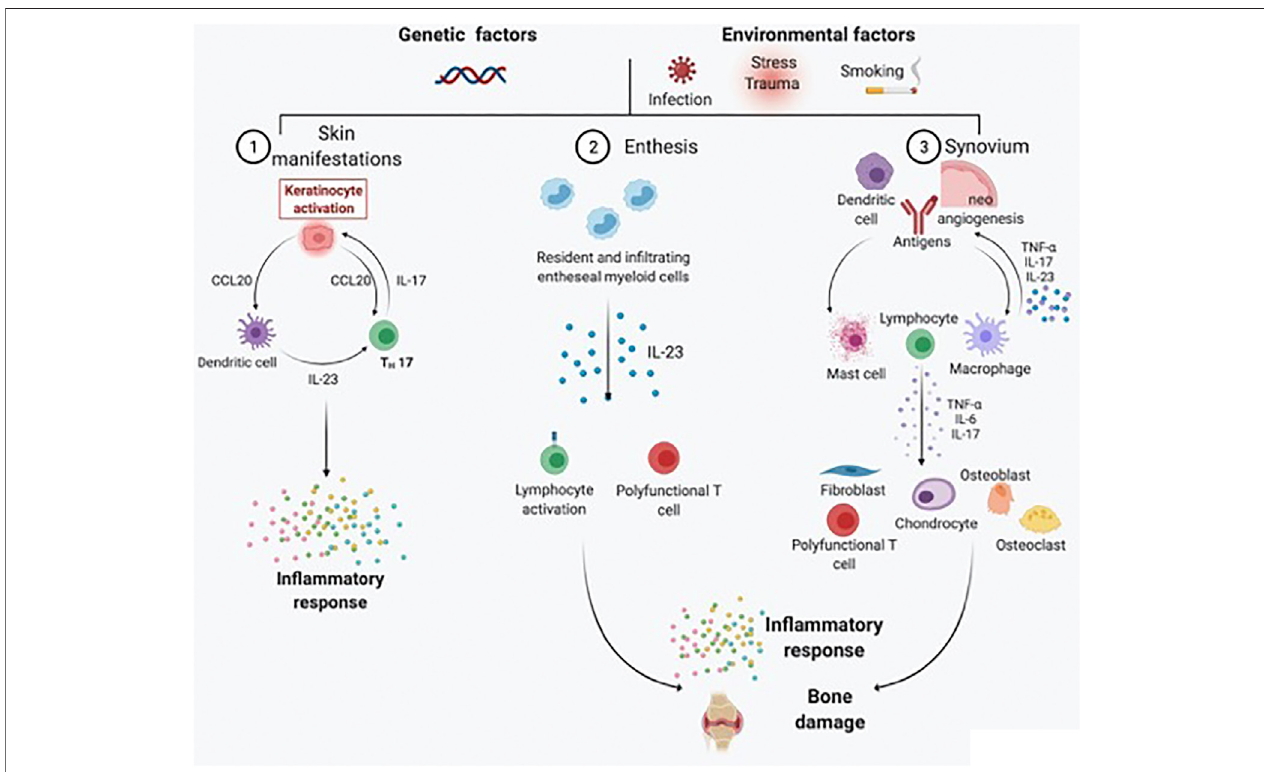
FIGURE 1 | Schematic representation of the main pathogenic processes driving PsA development and chronicity. PsA is a heterogeneous chronic disease, with skin, entheseal, and synovial tissue involvement occurring in different proportions across patients under genetic and environmental triggers. For skin manifestations, activated dendritic cells secrete predominantly IL-23, which in turn induces the differentiation of naïve T cells into Th17 cells. IL-17 is responsible for keratinocyte activation and subsequent perpetuation of skin in fl ammation. At the entheseal level, resident and in fi ltrating entheseal myeloid cells produce IL-23, which is responsible for lymphocyte activation and the in fl ammatory response, as well as bone damage. Psoriatic synovitis, on the contrary, is characterized by tortuous and immature neoangiogenesis, with antigen presentation by dendritic cells and macrophages leading to lymphocyte activation. As a result, the synovial in fl ammatory in fi ltrate is rich in activated lymphocytes, mast cells, and macrophages. Polyfunctional T cells are responsible for the production of several types of proin fl ammatory cytokines (e.g., TNF- α , IL-17A, GM-CSF, and IFN- γ ) in the synovial membrane and synovial fl uid. The proin fl ammatory cytokine milieu further activates fi broblast-like synoviocytes, chondrocytes, osteoblasts, and osteoclasts, resulting in bone damage.